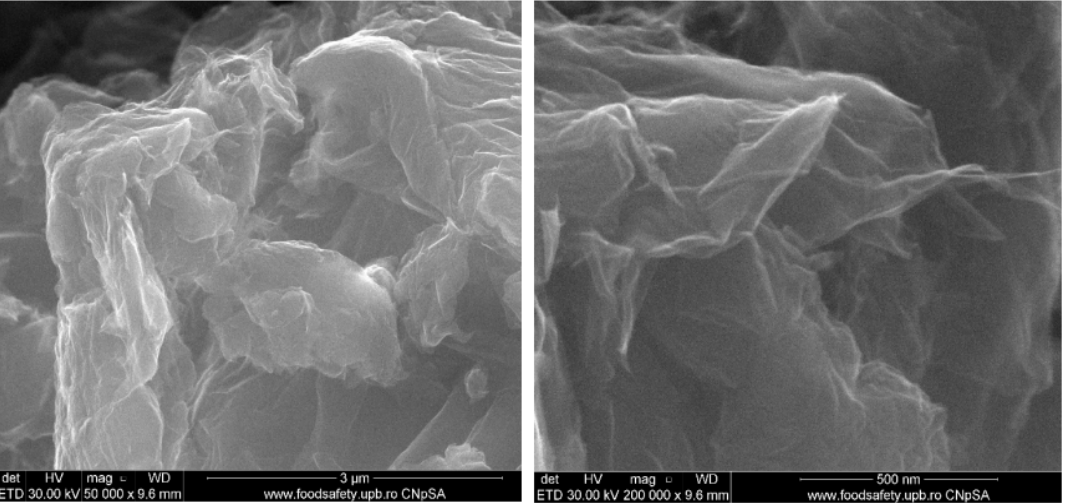
Figure 2. Microscopy analysis of a graphene oxide support morphology at 1000×, 10 kX. Reprinted from [116].